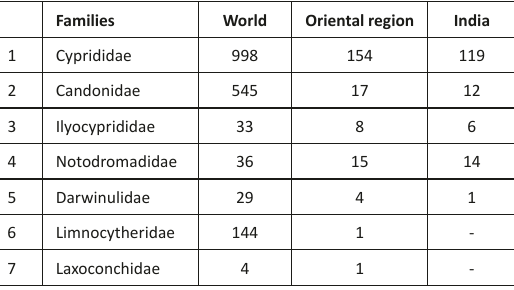
Table 2. Family wise Ostracoda species account from India Families